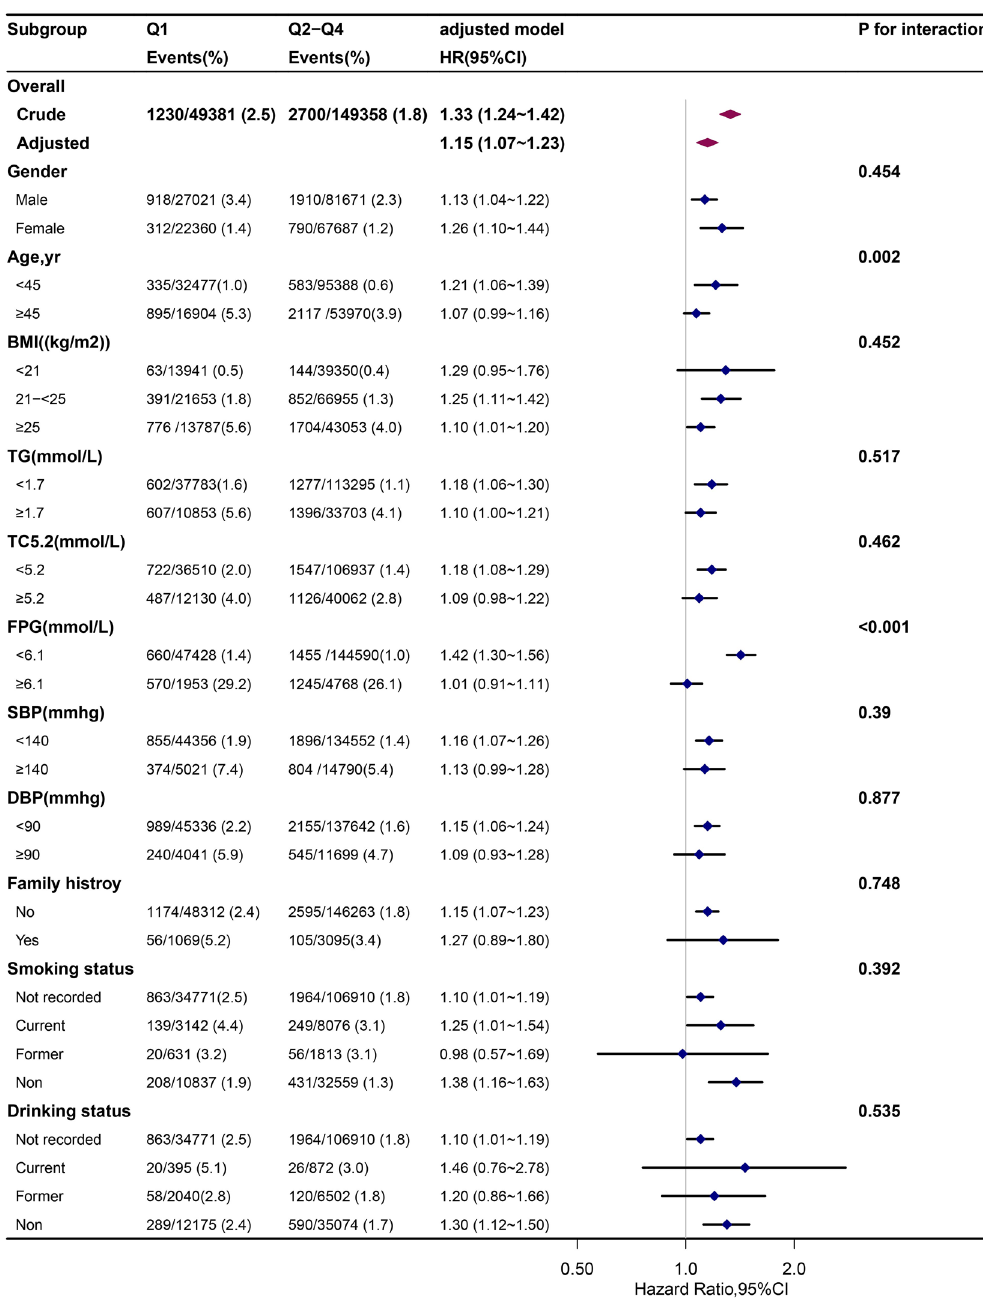
the general population. Three large Asian population studies (n = 9667 19 , n = 57587 20 and n = 41439 21 participants, also showed an association between serum creatinine levels and the risk of type 2 diabetes in both men and women. In our cohort study, n = 198739, we adjusted for more covariables (established risk factors), including age, sex, BMI, blood pressure, lipids, fasting blood glucose and genetic history of diabetes. We concluded that a more robust low level of creatinine is a risk factor for diabetes. Current research suggests that low levels of creatinine are a risk factor for diabetes. The range of creatinine in the low-level group currently studied is at baseline: 0.4–0.6 16 , < 0.7 19 , 0.38–0.69 17 , 0.3–0.78 (27–70 umol/L) 20 , < 0